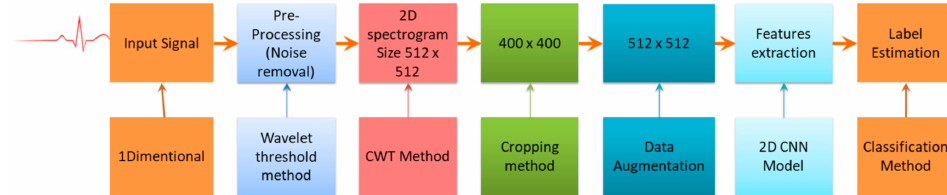
Figure 4. Complete procedures in ECG signal